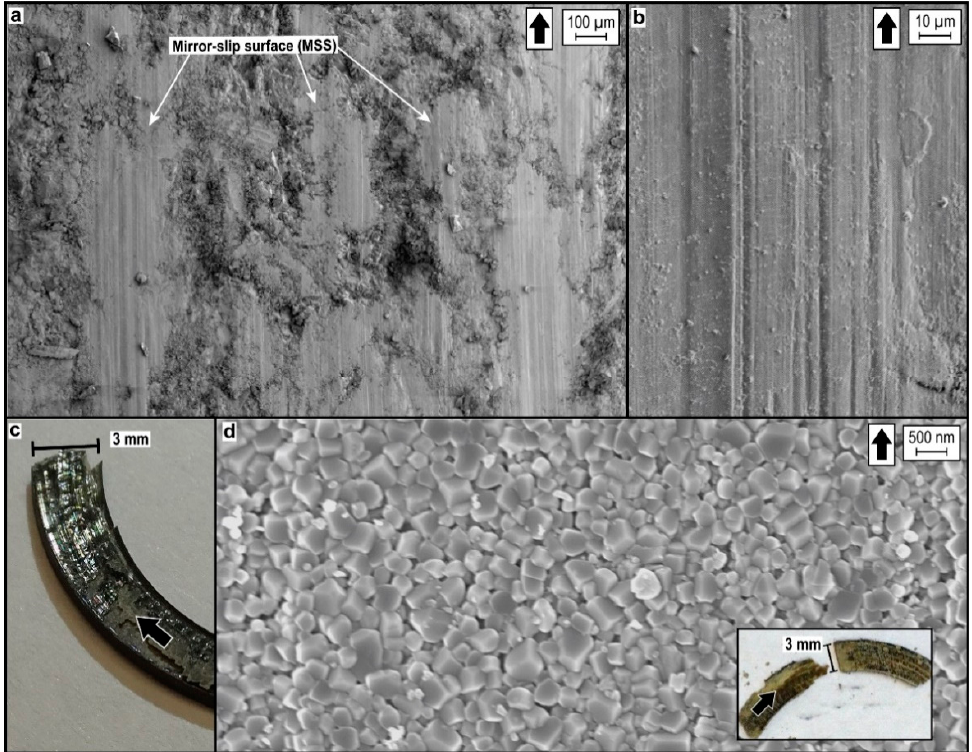
Figure 5. Principal slip zones with mirror-slip surfaces formed in simulated calcite gouge sheared in HVF tests ( v ≥ 10 − 4 ms − 1 ). ( a , b ) Secondary electron (SE) micrographs. From [115]. ( c ) Sample fragment recovered from an experiment conducted using 0.1 ≤ v ≤ 100 µ ms − 1 , σ ne ff = 50 MPa, T = 550 ◦ C,